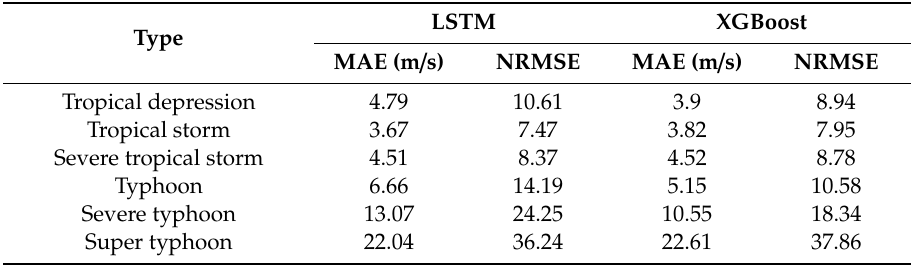
Table 12. LSTM and XGBoost model errors for di ff erent tropical cyclone intensity levels at a 24 h lead time.